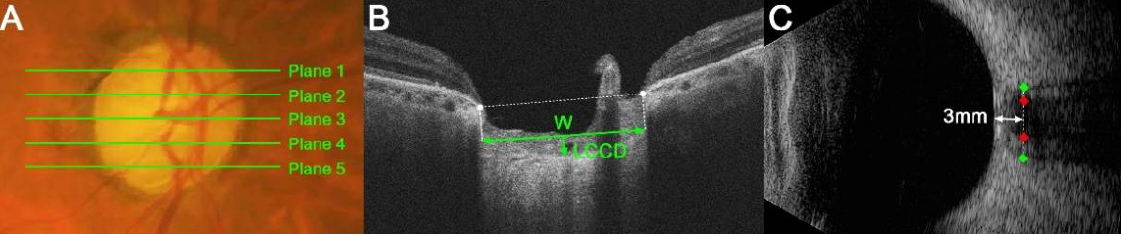
Figure 1. Measurements of the lamina cribrosa (LC) curvature index (LCCI), optic nerve sheath diameter (ONSD) and optic nerve diameter (OND). ( A ) Stereoscopic optic disc photograph image. The five horizontal green lines indicate the locations where the measurements were performed. ( B ) Cirrus HD OCT B-scan images were obtained at plane 4 as shown in ( A ). The LCCI was measured by dividing the LC curve depth (LCCD) by the length of the LC surface reference line (W) within Bruch’s membrane opening (BMO) and multiplying by 100. ( C ) Transorbital ultrasonographic im- age. The ONSD (distance between green dots) and OND (red dots) were assessed perpendicular to the scanning place 3 mm behind the globe.